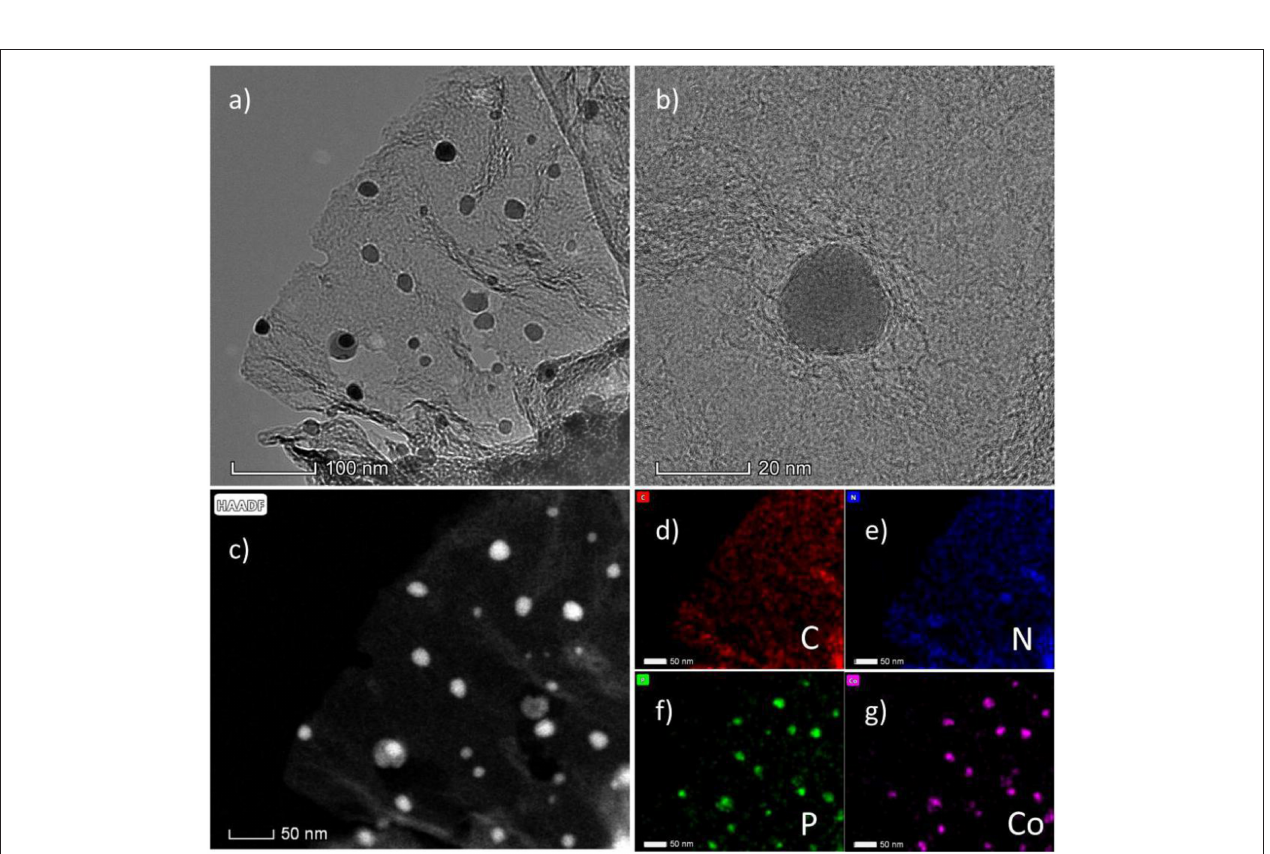
FIGURE 2 | (a,b) TEM images of CoP-CGP2; (c) HAADF-STEM image and (d–g) EDS elemental mapping.